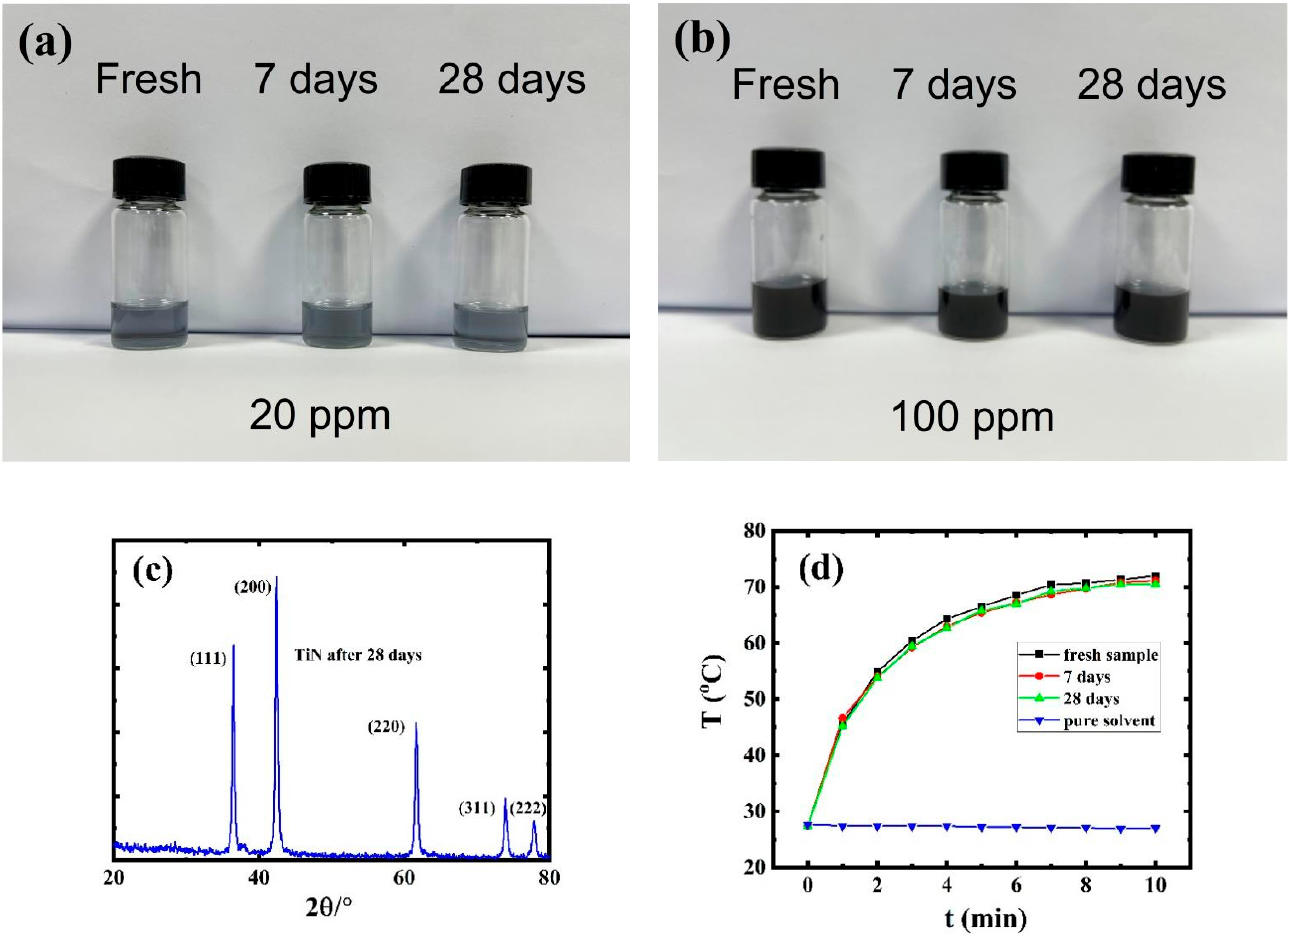
Figure 2. ( a , b ) Photographs of TiN QD solutions after different time durations (20 ppm for ( a ) and 100 ppm for ( b )). ( c ) XRD pattern of the TiN QDs after 28 days and ( d ) photothermal behavior under irradiation with an 808 nm laser of a 50 ppm TiN QD solution after different time durations (laser power: 1 W/cm 2 ).